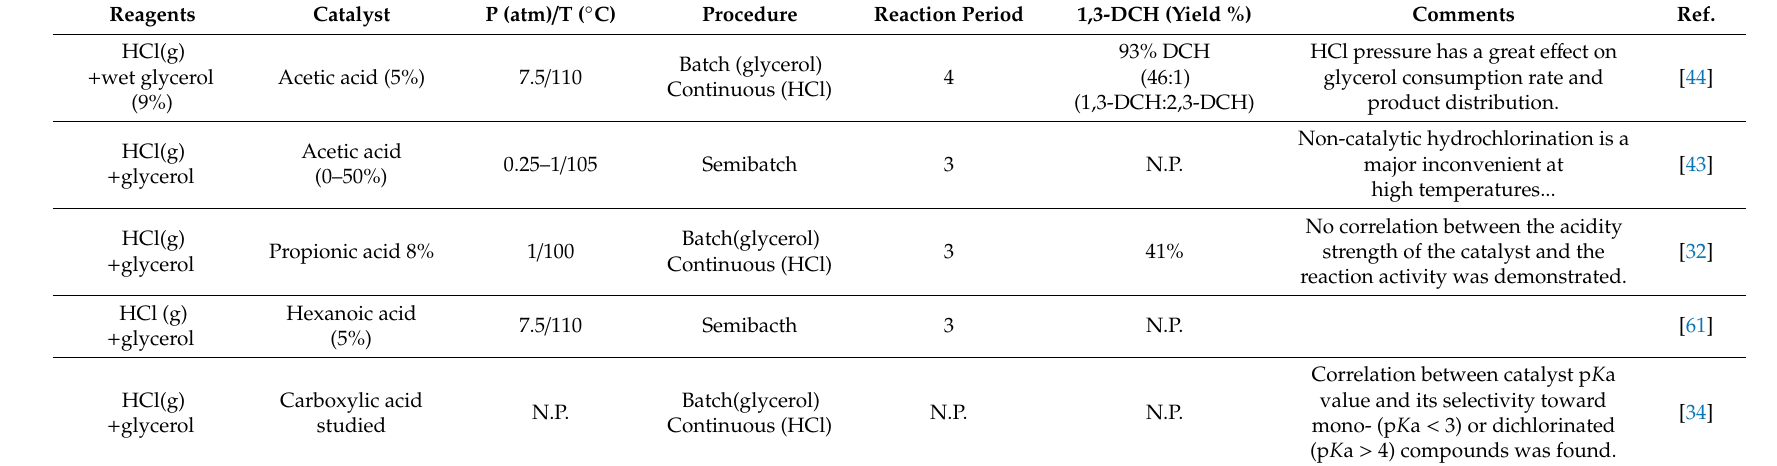
Table 1. E ff ect of several conditions on the synthesis of